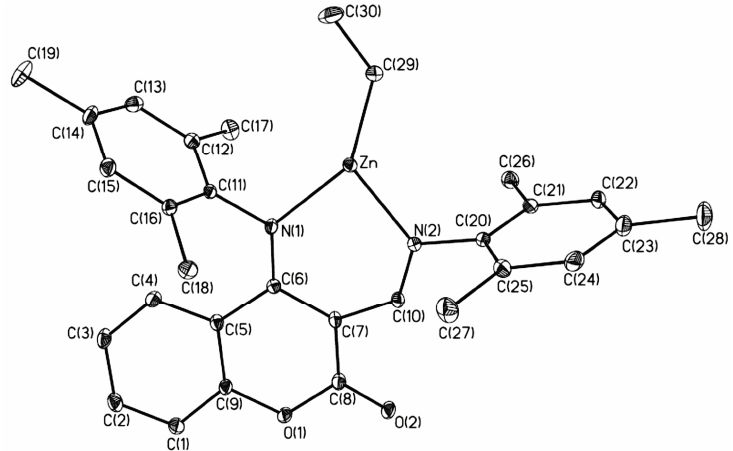
Figure 1. Molecular structure of 1 . A continuous 1D-array in 1 is achieved by coordination of carbonyl groups to metal centers.